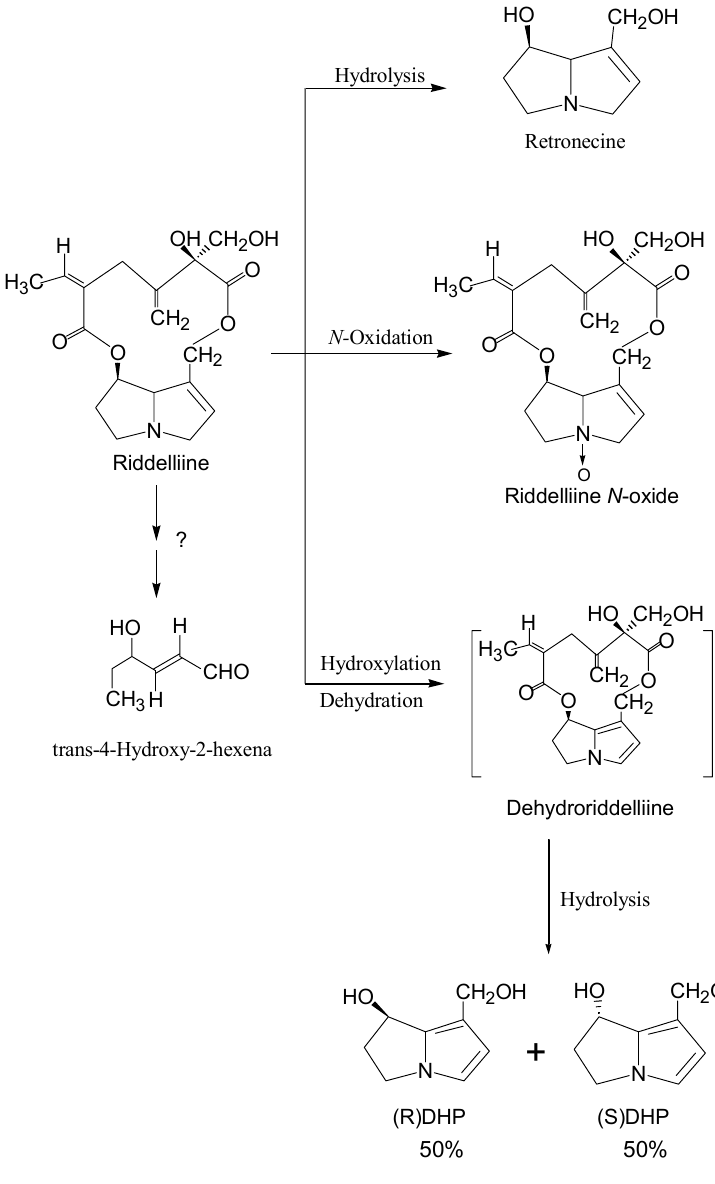
Figure 2. Metabolism pathways of